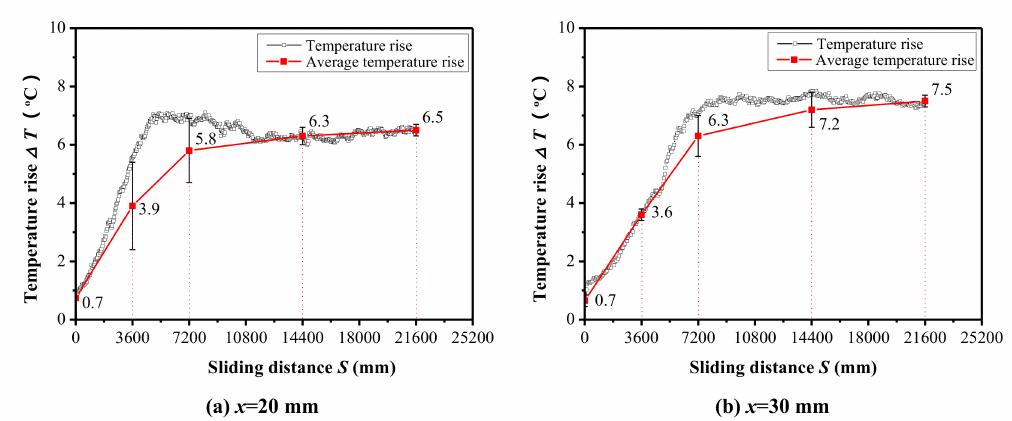
Figure 7. The evolution of temperature rise under different strokes. ( a ) Stroke: 20 mm, load: 100 N; ( b ) stroke: 30 mm, load: 100 N.